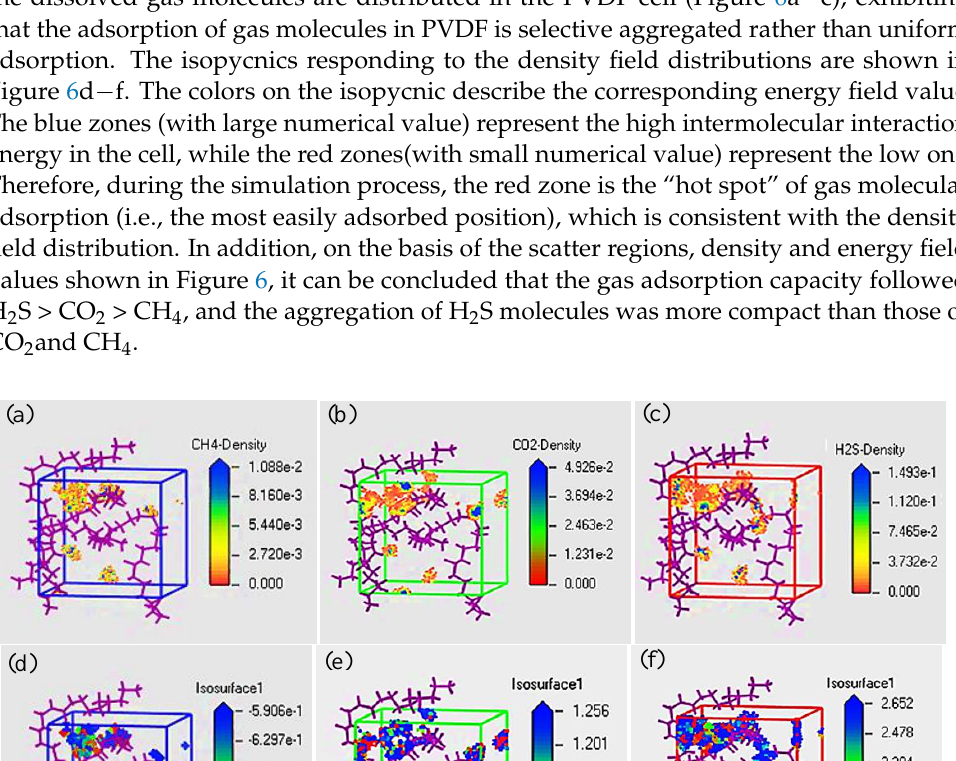
Figure 5. Isosteric heat of adsorption of gas molecules in PVDF at different conditions.